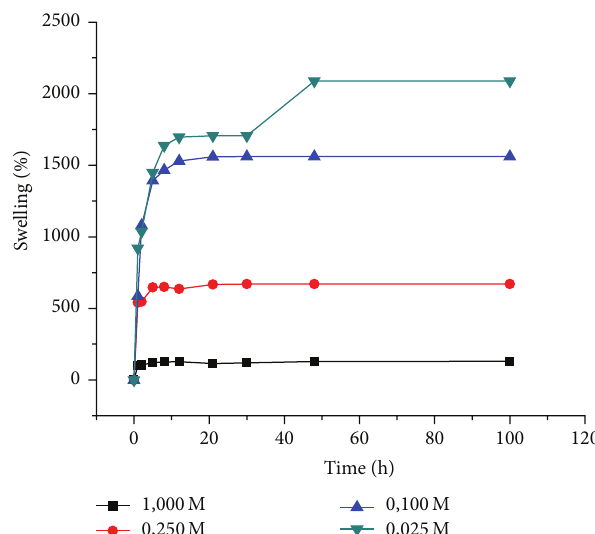
Figure 7: Time dependence of swelling ratio for hyperbranched PAcHP obtained from bulk polymerization (ionic strength).